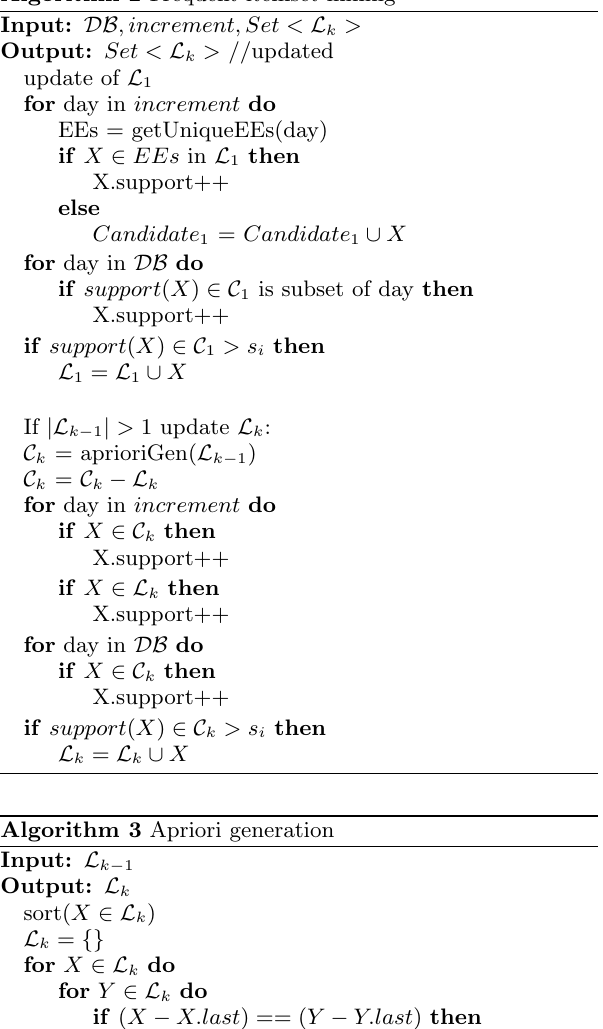
Algorithm 2 Frequent itemset mining